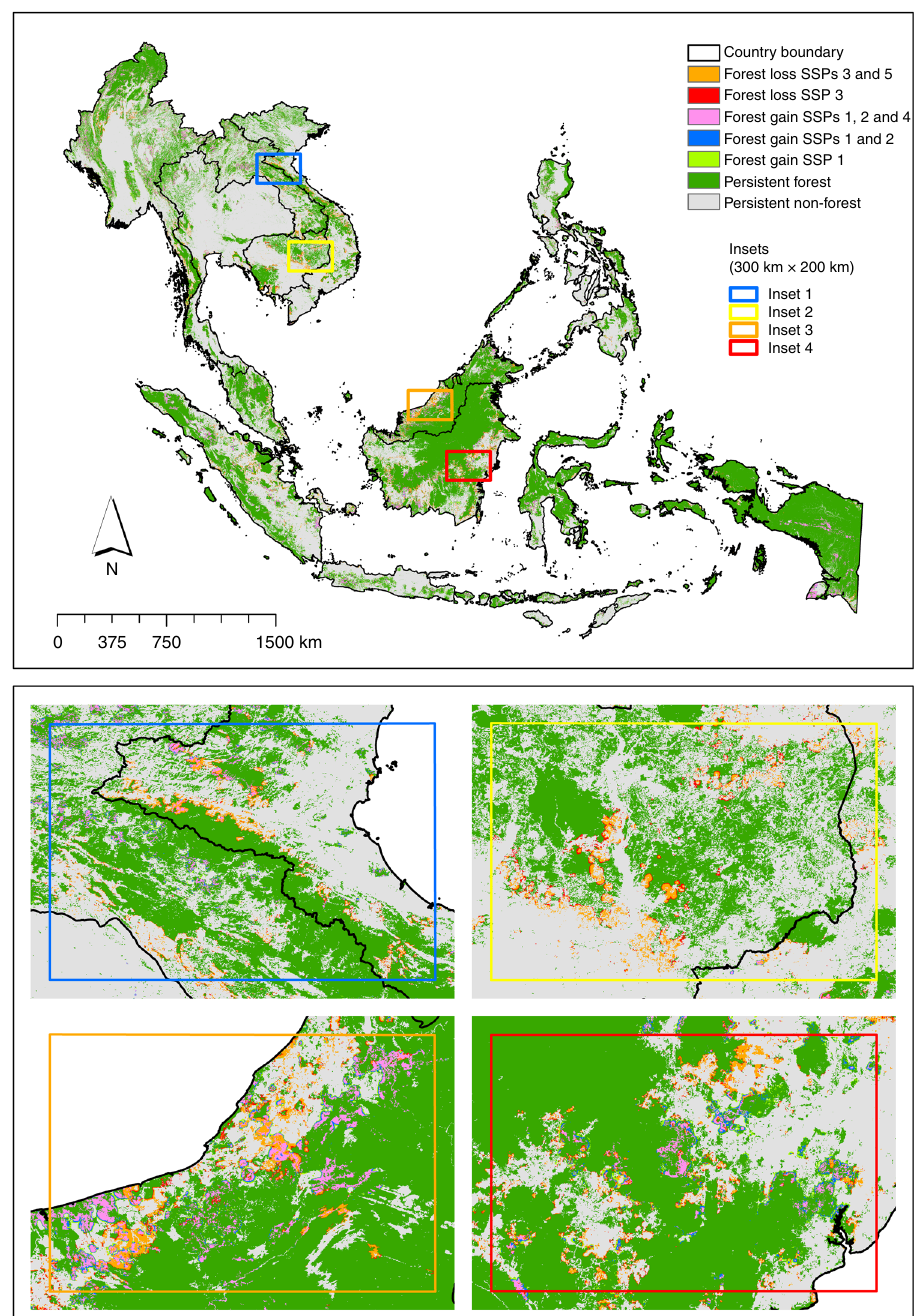
Fig. 1 Maps showing the spatially allocated projected forest cover changes in Southeast Asia under the fi ve shared socioeconomic pathways (SSPs) (2015 – 2050). The four insets show the spatially allocated projected forest cover changes in some parts of Laos and Vietnam (inset 1), Cambodia (inset 2), Malaysia (inset 3) and Indonesia (inset